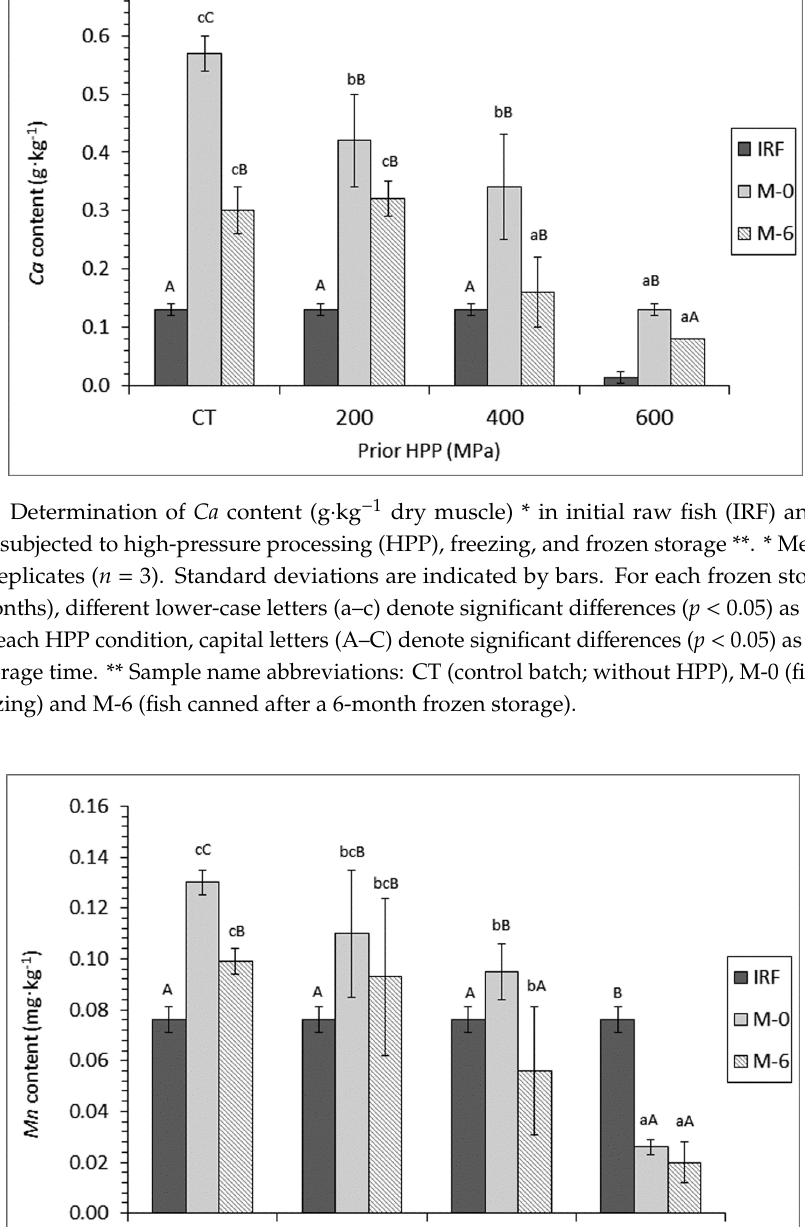
Table 3. Determination (mg·kg −1 dry muscle) of different transition metal elements ( Fe , Co , and Cu ) contents * in initial raw fish and canned mackerel subjected to different processing conditions